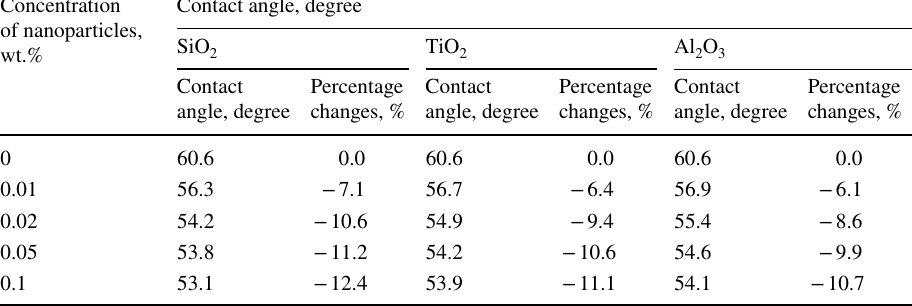
various concentrations of nanoparticles in brine No.